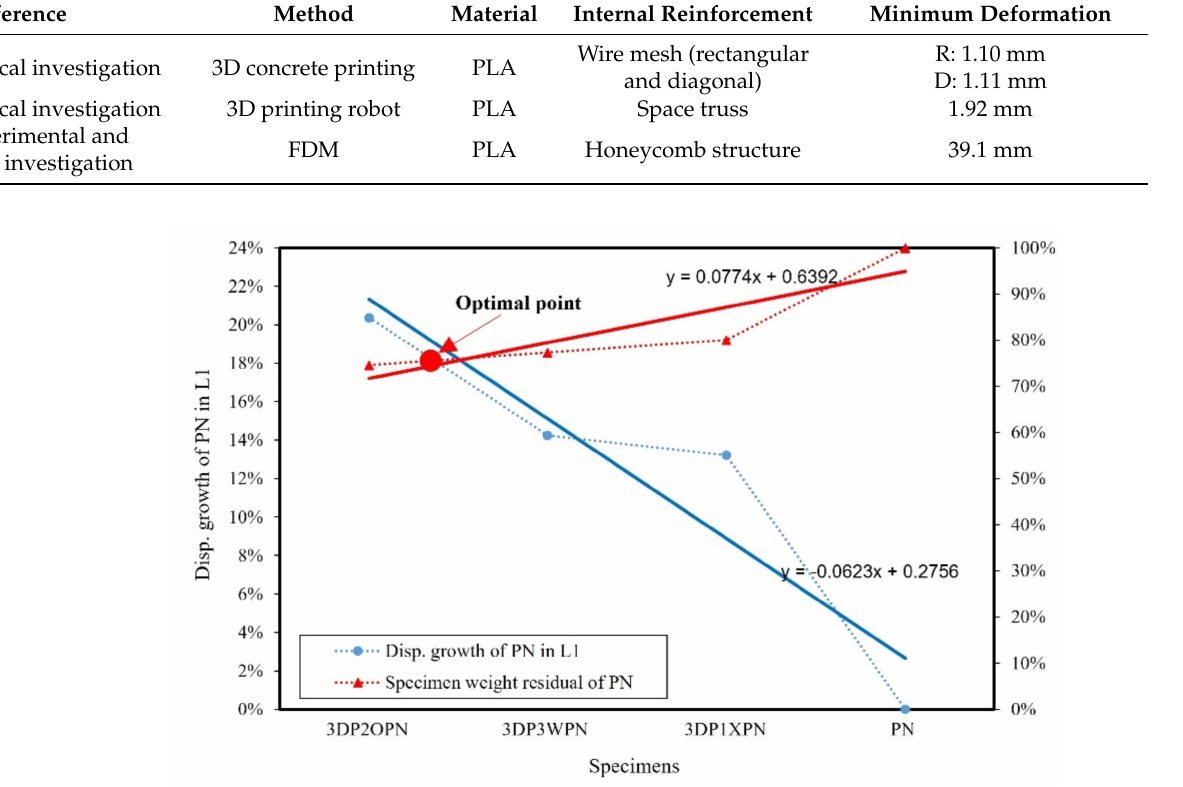
Figure 19. Optimal point of the later load test in loading protocol #1 (L1).